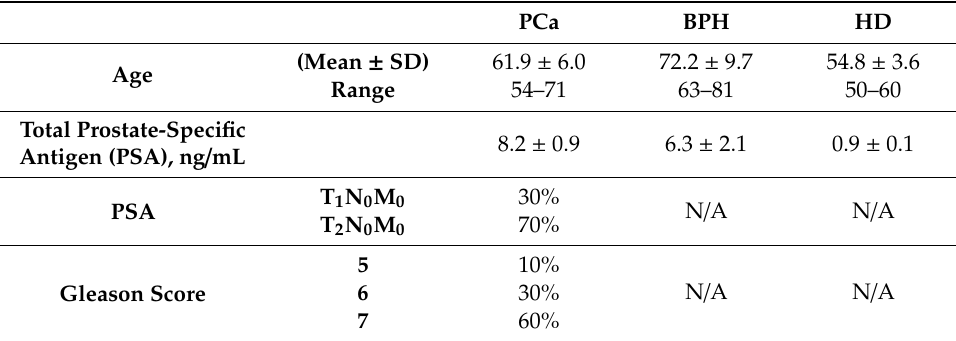
Table 11. Overview of the study